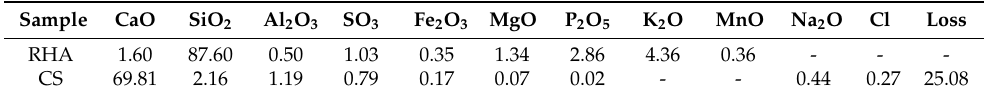
Table 1. Composition analysis of rice husk ash (RHA) and carbide slag (CS) (%).